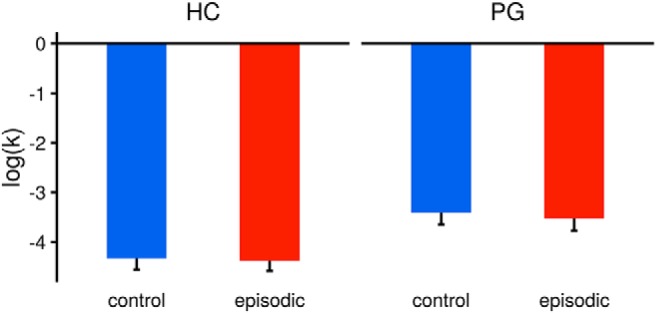
Behavioral results. Estimates of the k parameter of the hyperbolic discounting function were obtained for every participant and condition. An ANOVA (see Results) revealed a significant effect of group and a trend-level effect of condition on impulsivity parameters, but no significant group × condition interaction. PG, pathological gamblers; HC, healthy controls. Error bars indicate ±1 standard error of the mean.